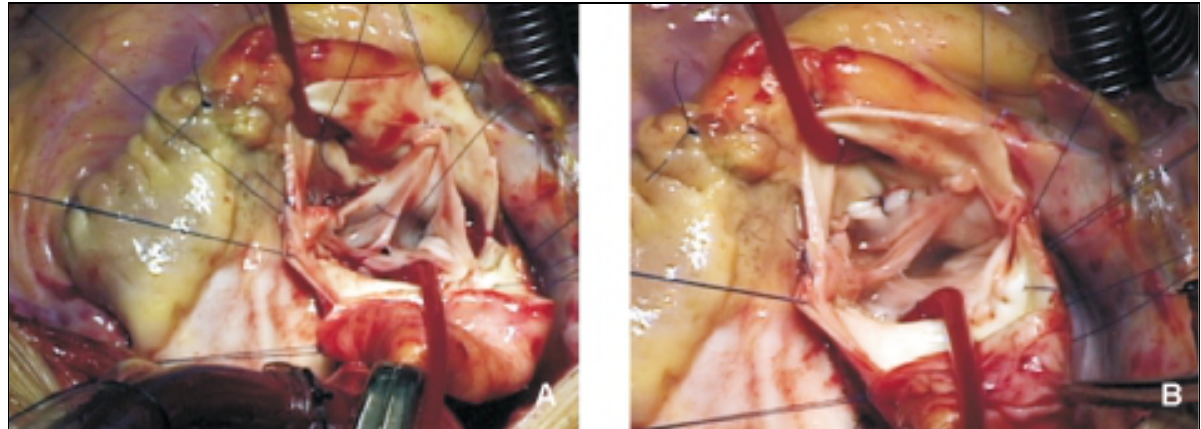
Fig. 2 - Técnica de implante subcoronariano. A- Início da sutura distal na parede do seio de Valsalva direito. A sutura inicia-se logo abaixo do óstio da coronária direita. B- Aspecto final do